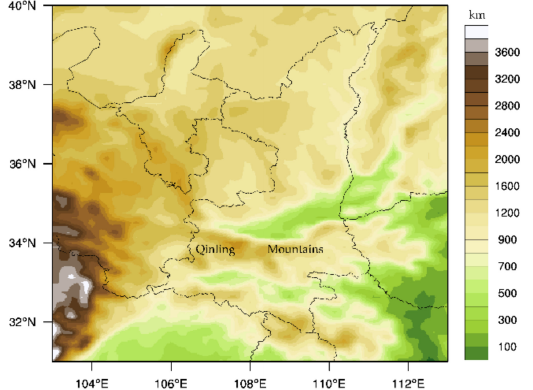
Figure 1. Study area: Qinling Mountains and its surrounding areas (31 ◦ –40 ◦ N, 103 ◦ –113 ◦